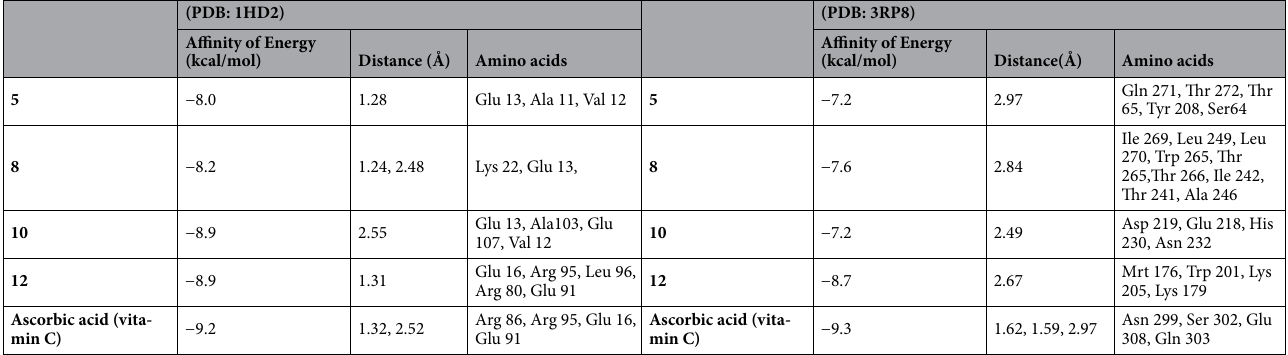
Table 2. The molecular docking metal complexes with PDBID:1HD2 and